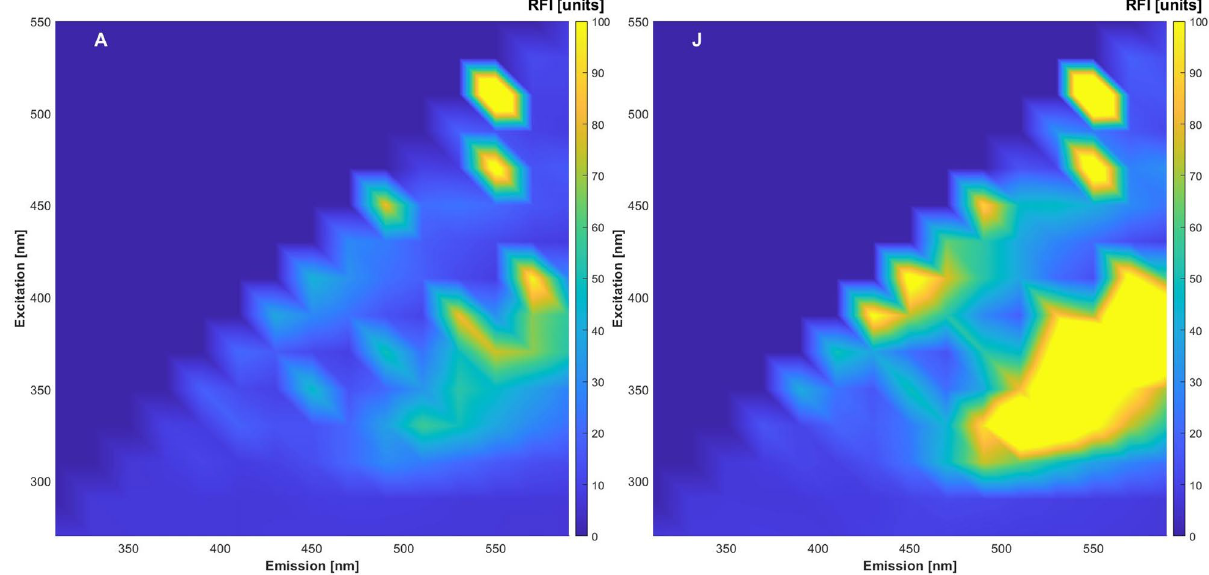
Figure 2. Representative fluorescence spectra (mean of 5) of two samples before